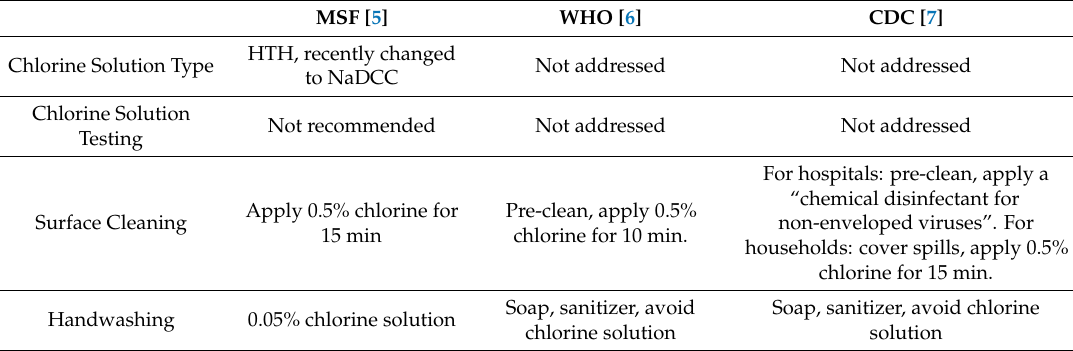
Table 1. Inconsistencies in International EVD Chlorine